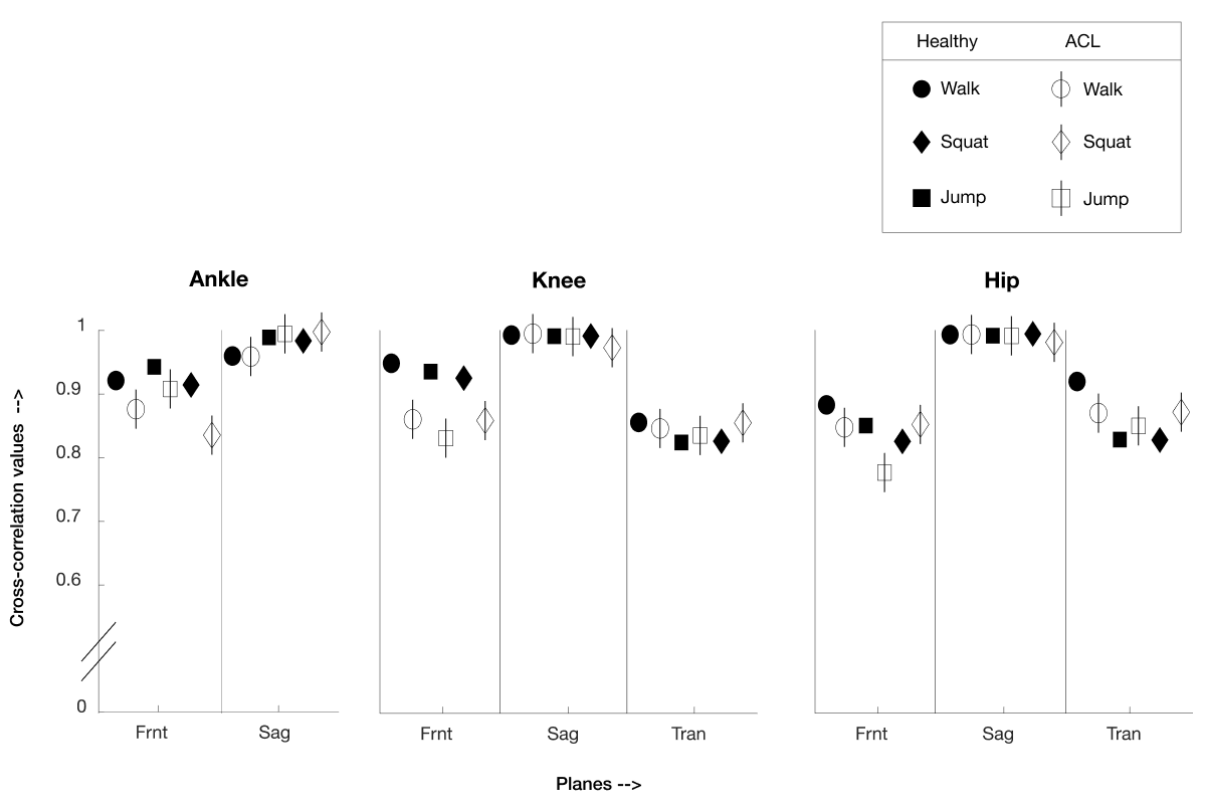
Figure 8. Mean cross-correlation values between MVN Analyze and MoJoXlab for healthy participants (black) and anterior cruciate ligament reconstruction participants (white), presented in a graphical format for visualization and overall comparison purposes. Values close to 1 indicate a very high correlation (circle—values for the walk task, square—values for jump task, and diamond—values for squat task; planes: Frnt—frontal, Sag—sagittal, and